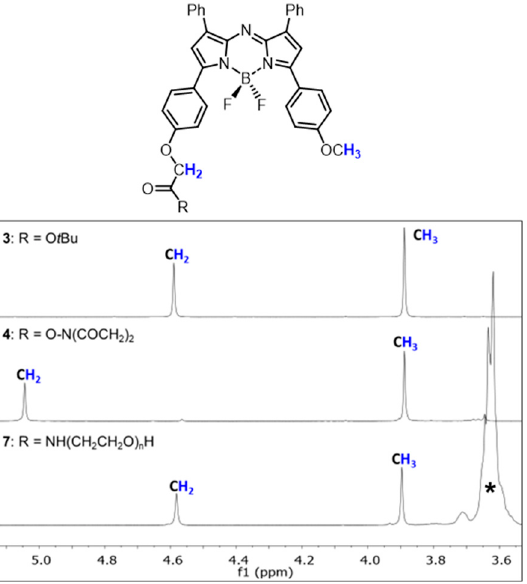
Figure 2. Representative partial 1 H NMR analysis for the conversion of 3 into 4 and subsequently into 7 . NMRs show chemical shift change in methylene and methoxy protons (coloured blue) as indicated in the structures. * PEG polymer.